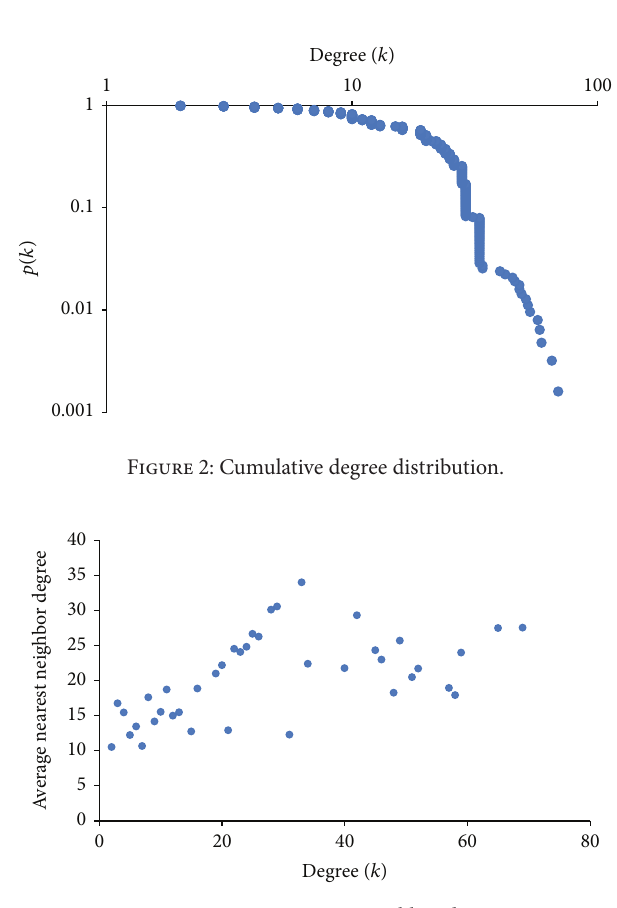
Figure 3: Average nearest neighbor